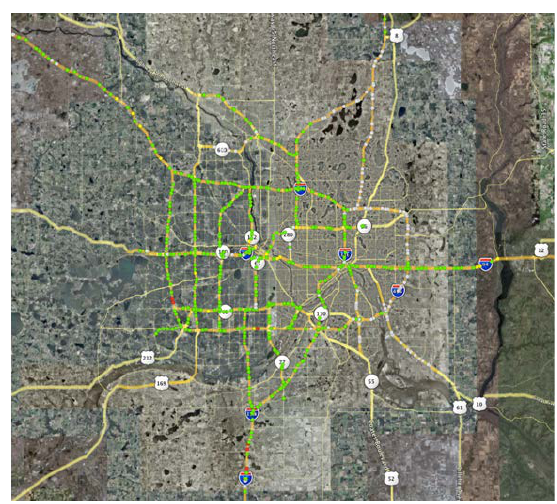
Figure 3. Comparison of PHF Computed by Approaches A and B